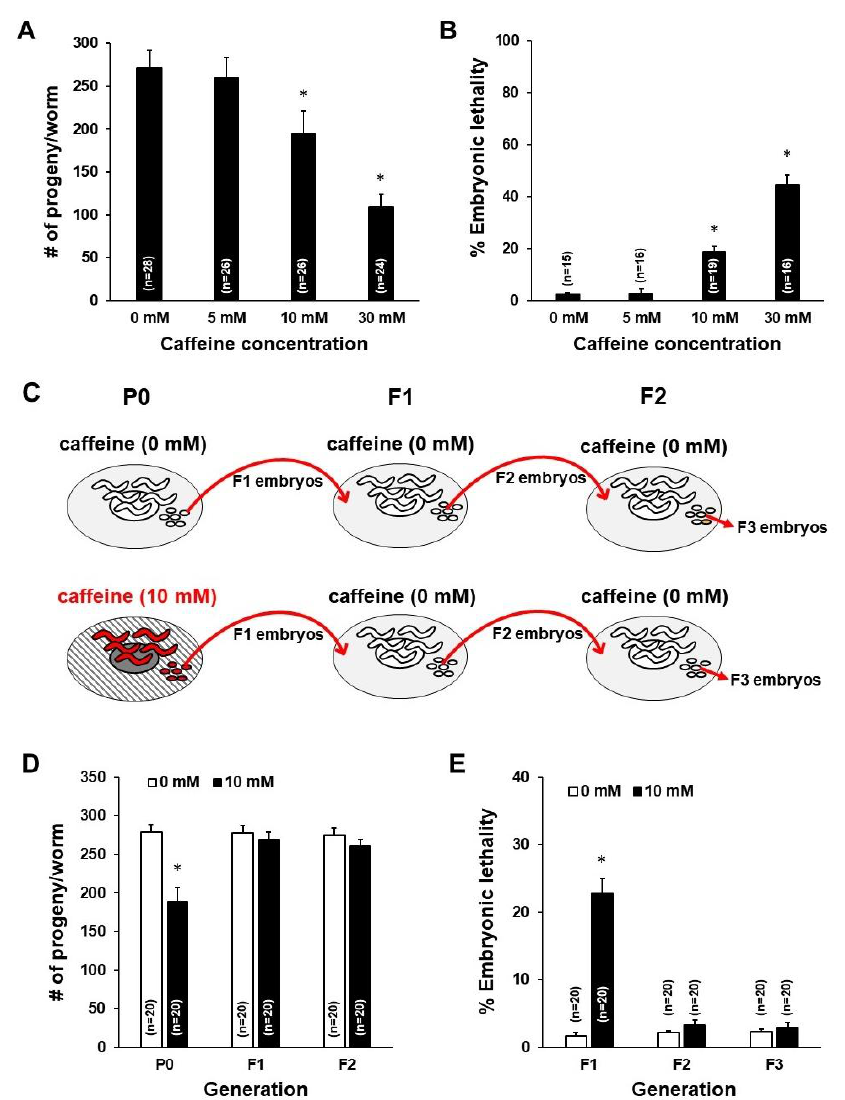
Figure 2. Caffeine intake caused a reduction in fertility of P0 mothers and an increase in F1 embryonic lethality in Caenorhabditis elegans . ( A ) Total number of progenies by caffeine-ingested mothers (5, 10, and 30 mM) compared to mothers with a caffeine-free diet (0 mM). * p < 0.05. ( B ) The percentage of embryonic lethality among the total number of progenies produced by caffeine-ingested P0 mothers that were fed 0, 5, 10, and 30 mM of caffeine at the L4 stage for 24 h. * p < 0.05. ( C ) A scheme of assays for intergenerational effects of caffeine intake by P0 mothers . The P0 mothers were fed 10 mM of caffeine, and reproduction and growth were measured from P0 to F2 generation for analysis of intergenerational effects of caffeine intake by P0 mothers. ( D ) The total number of progenies produced by caffeine-ingested P0 mothers and their offspring (black bars) compared to caffeine-free diet P0 mothers and their offspring (white bars). * p < 0.05. ( E ) The percentage of embryonic lethality among the total number of progenies produced by caffeine-ingested P0 mothers and their offspring (black bars), and caffeine-free diet P0 mothers and their offspring (white bars). Error bars represent SD. * p < 0.05.